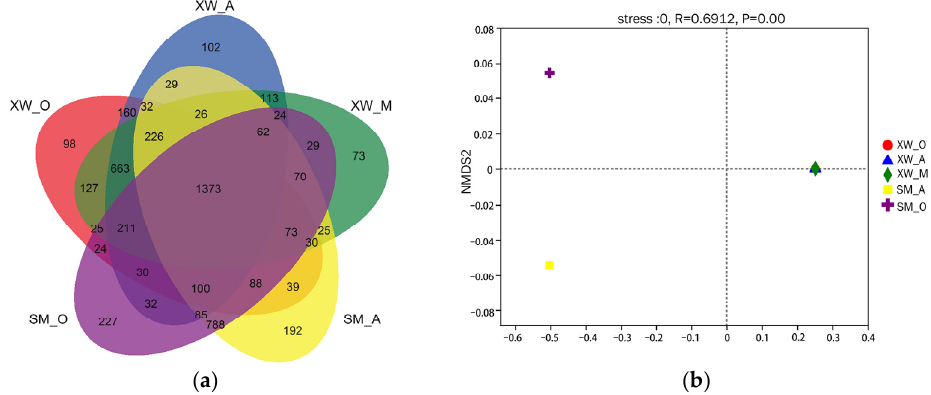
Figure 1. The similarity of the microbial community composition found in the wastewater treatment plants. ( a ) Venn diagram of the OTU distribution; ( b ) NMDS of the microbial community dynamics.